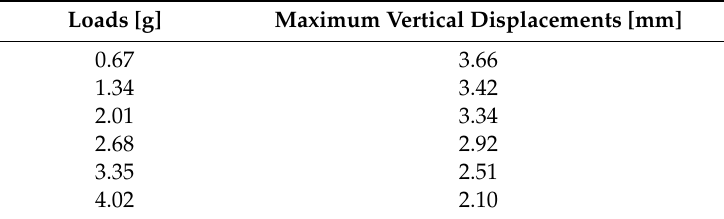
Table 2. Maximum vertical displacements against di ff erent